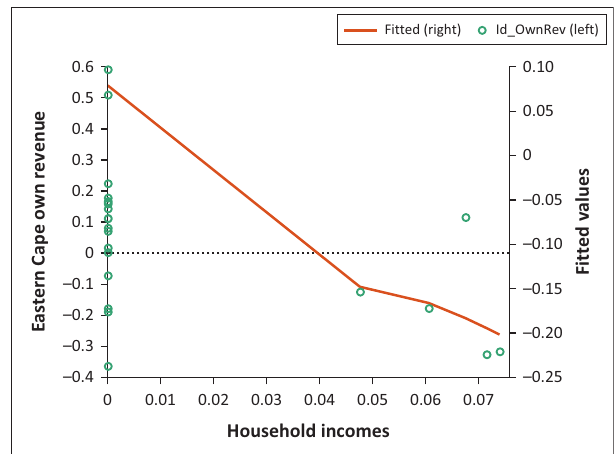
FIG URE 2: Relationship between own revenue and household